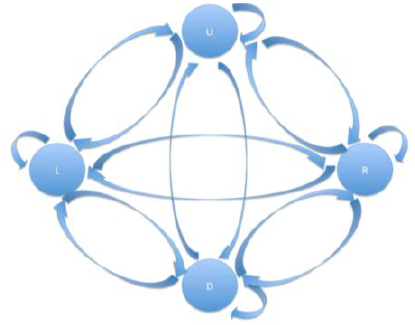
Figure 7. Flow chart for headMovement algorithm